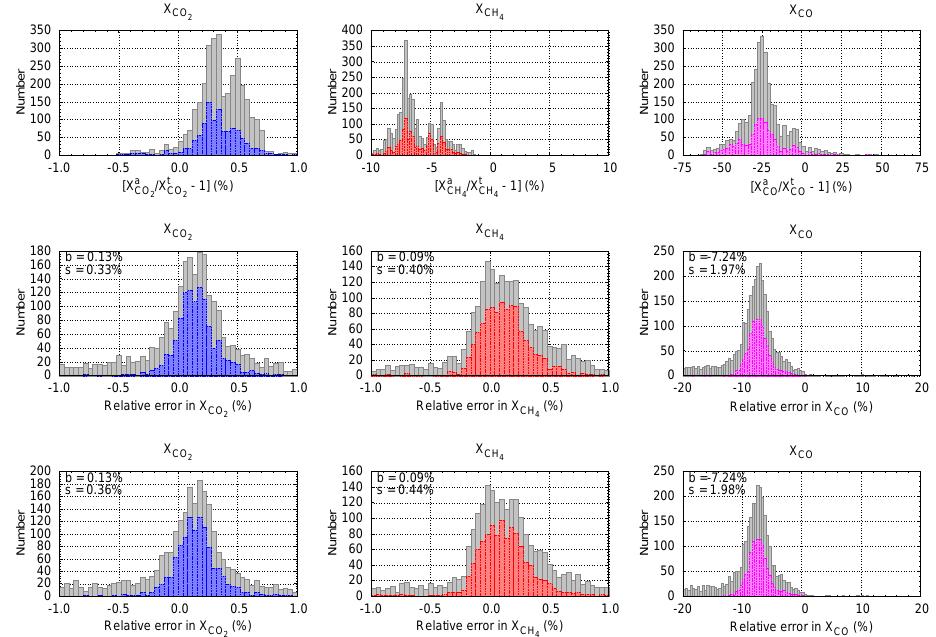
Fig. 15. The upper row compares the prior and true column amounts for the ensemble of scenes, both before and after the PPF. The lower rows present histograms of errors in retrieved X CO , X CH and X CO for the baseline configuration when the prior profiles are approximate, as described in the text. In the middle row the priors for the meteorology coincide with the truth (experiment 2), while in the bottom row the meteorology priors also are approximate (experiment 3). The biases ( b ) and standard deviations ( s ) quoted are for the histograms after the post-processing filters have been applied. 60